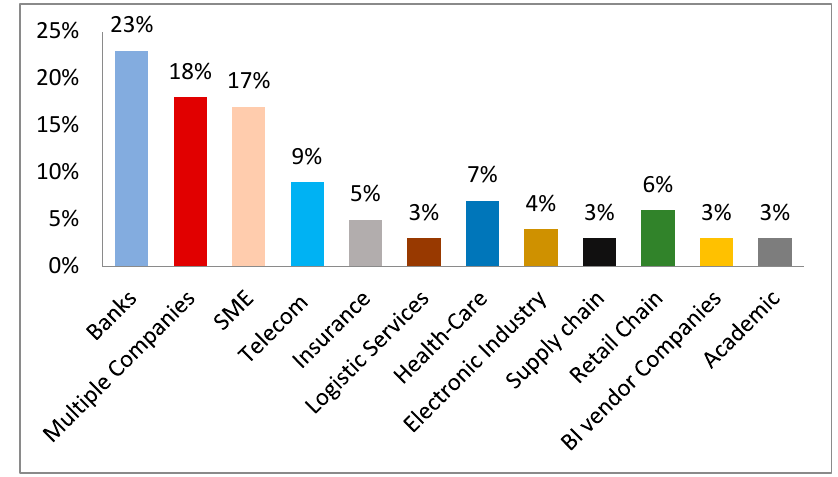
Figure 5. Sector ‐ wise distribution of articles. Figure 5. Sector-wise distribution of